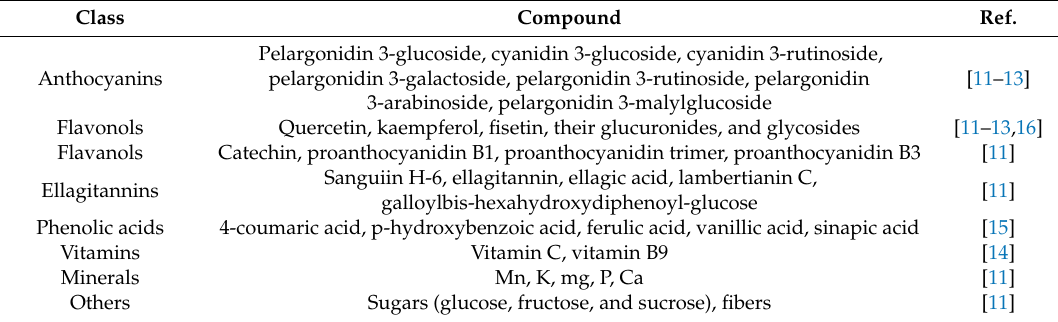
Table 1. Major (common) components in Fragaria L. aggregate fruits (adapted from